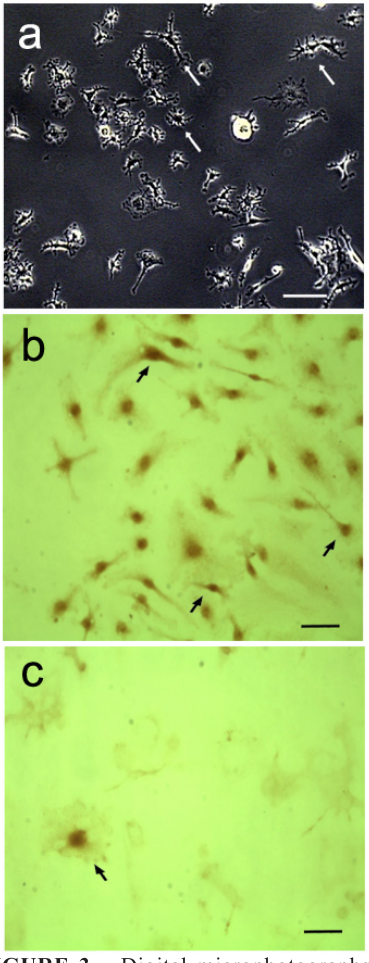
FIGURE 3 – Digital microphotographs of confluent cultured purified astrocytes from mouse spinal cord under phase contrast ( a ) and immunolabelled for GFAP ( b ) or CD11B ( c ). Immunoperoxidase technique was applied with DAB as a chomogen. GFAP and CD11B were markers for astrocytes and microglia, respectively. The majority of cultured cells were astrocytes labeled for GFAP (B) and only the minority of the cells were microglia labeled for CD11B (c). Bars: 20µm ( a ) and 30µm ( b , c )